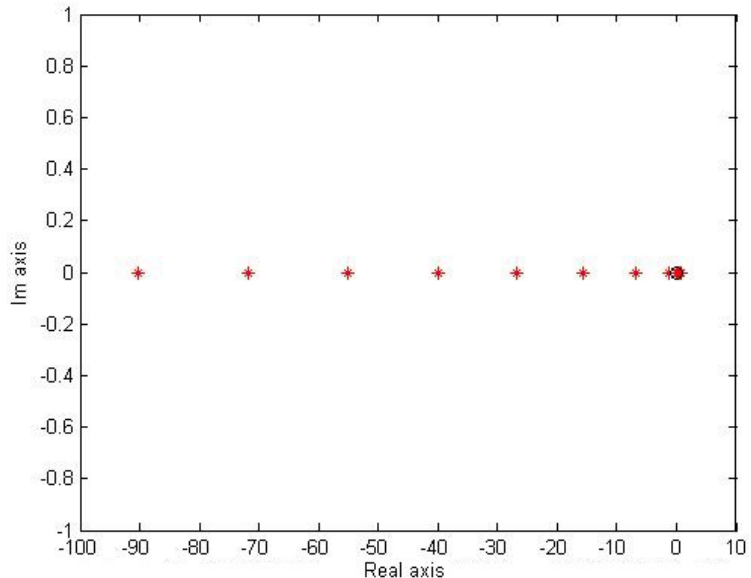
Figure 13. Energy eigenvalues of the PDM Hamiltonian associated with Gaussian single well type potential for 01.0 =λ .